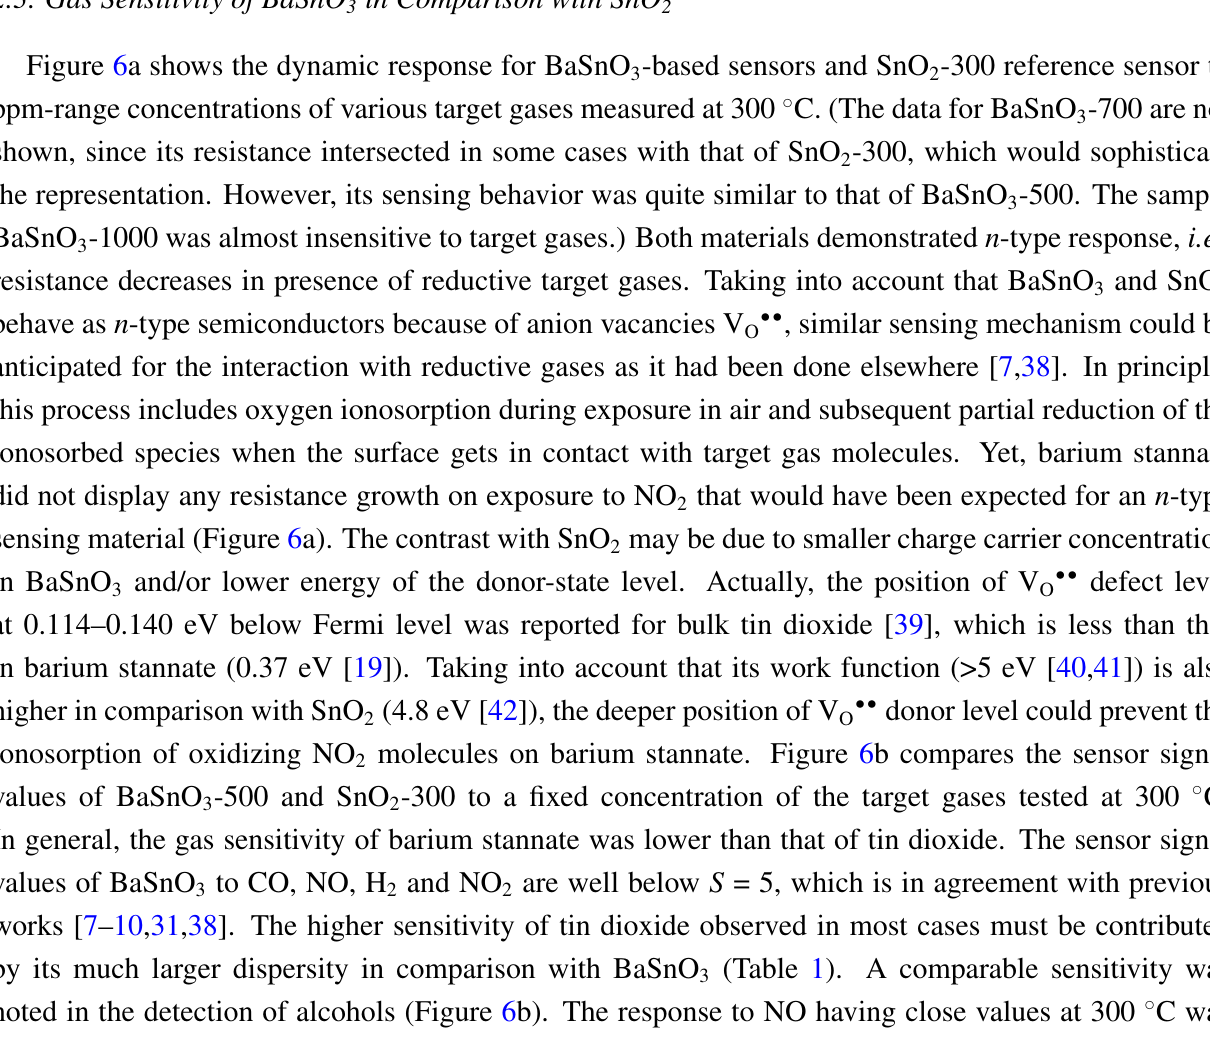
concentration measured at 300 ˝ C ( a ); 2 samples annealed at different 3